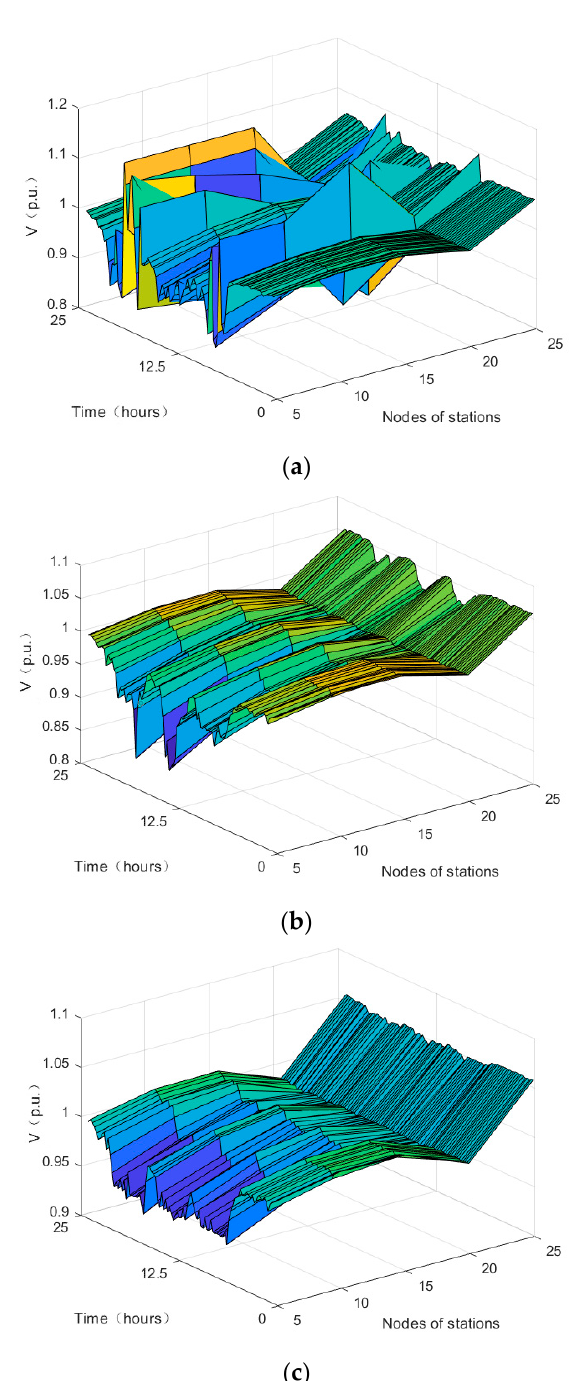
Figure 9. ( a ) Voltage values of stations under disorderly charging strategy; ( b ) Voltage values of stations under non-preferred charging strategy; ( c ) Voltage values of stations under collaborative optimization strategy.